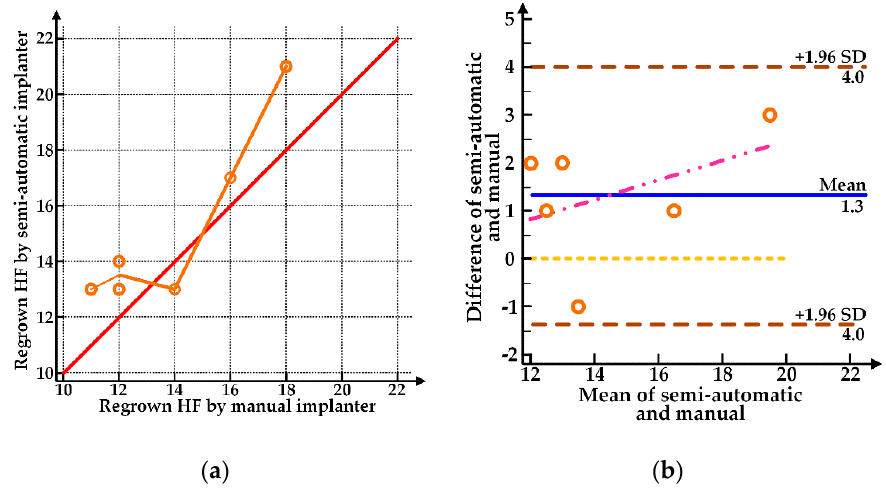
Figure 15. ( a ) Consistency and ( b ) comparison of engraftment rate.